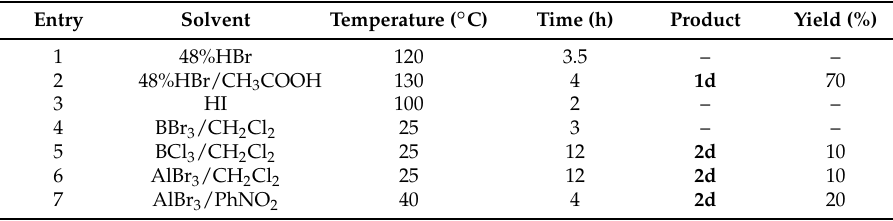
Table 3. O -Demethylation reaction of